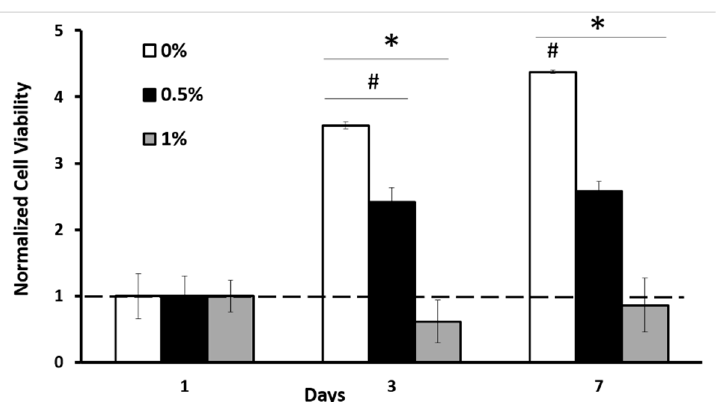
Figure 6. Cytotoxicity effect of genipin crosslinking with different genipin concentrations. # denotes a significant difference between time points, while (*) indicates a significant difference between sample groups, p < 0.05.